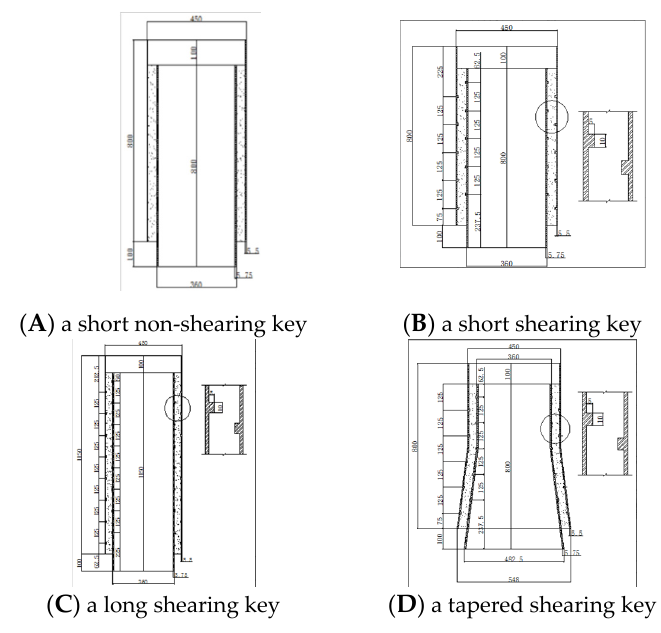
Figure 1. Specimens.